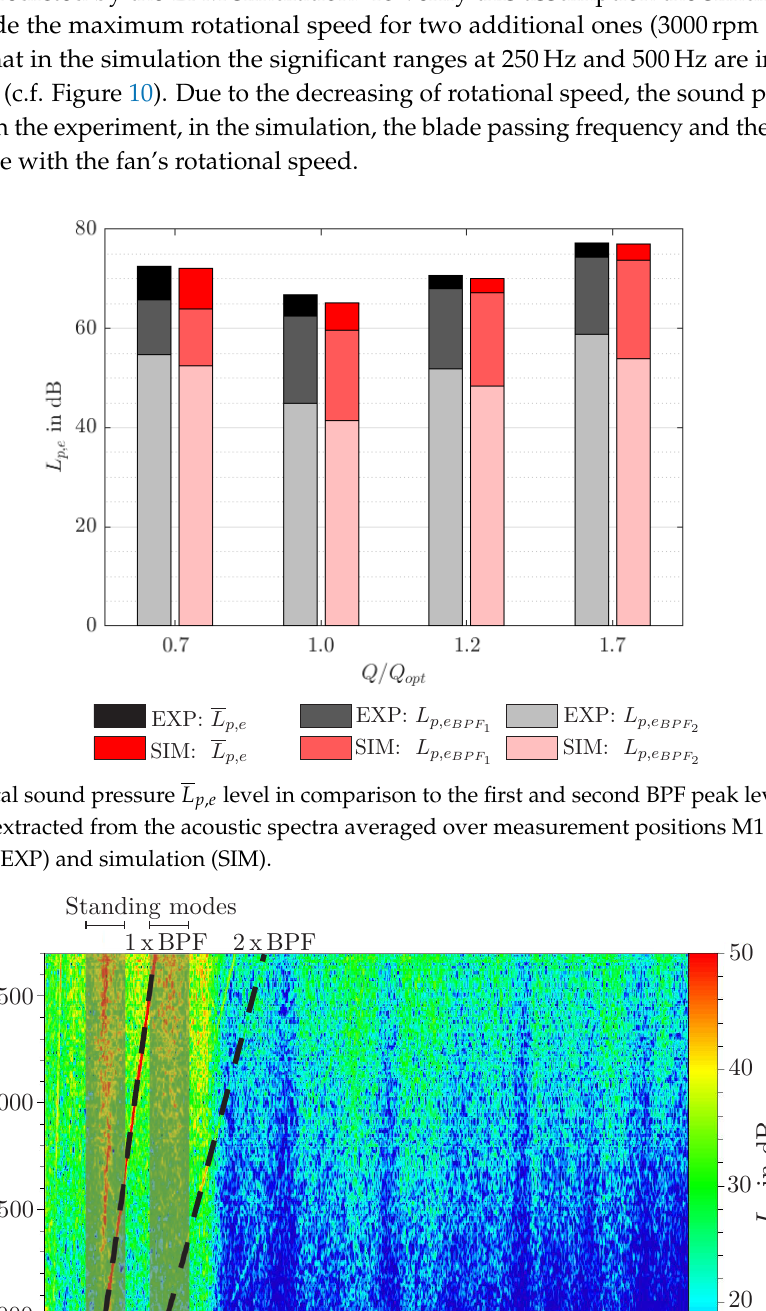
Figure 9. Campbell diagram of rotational speed test for Q / Q opt = 1.0 at microphone position M10 determined by